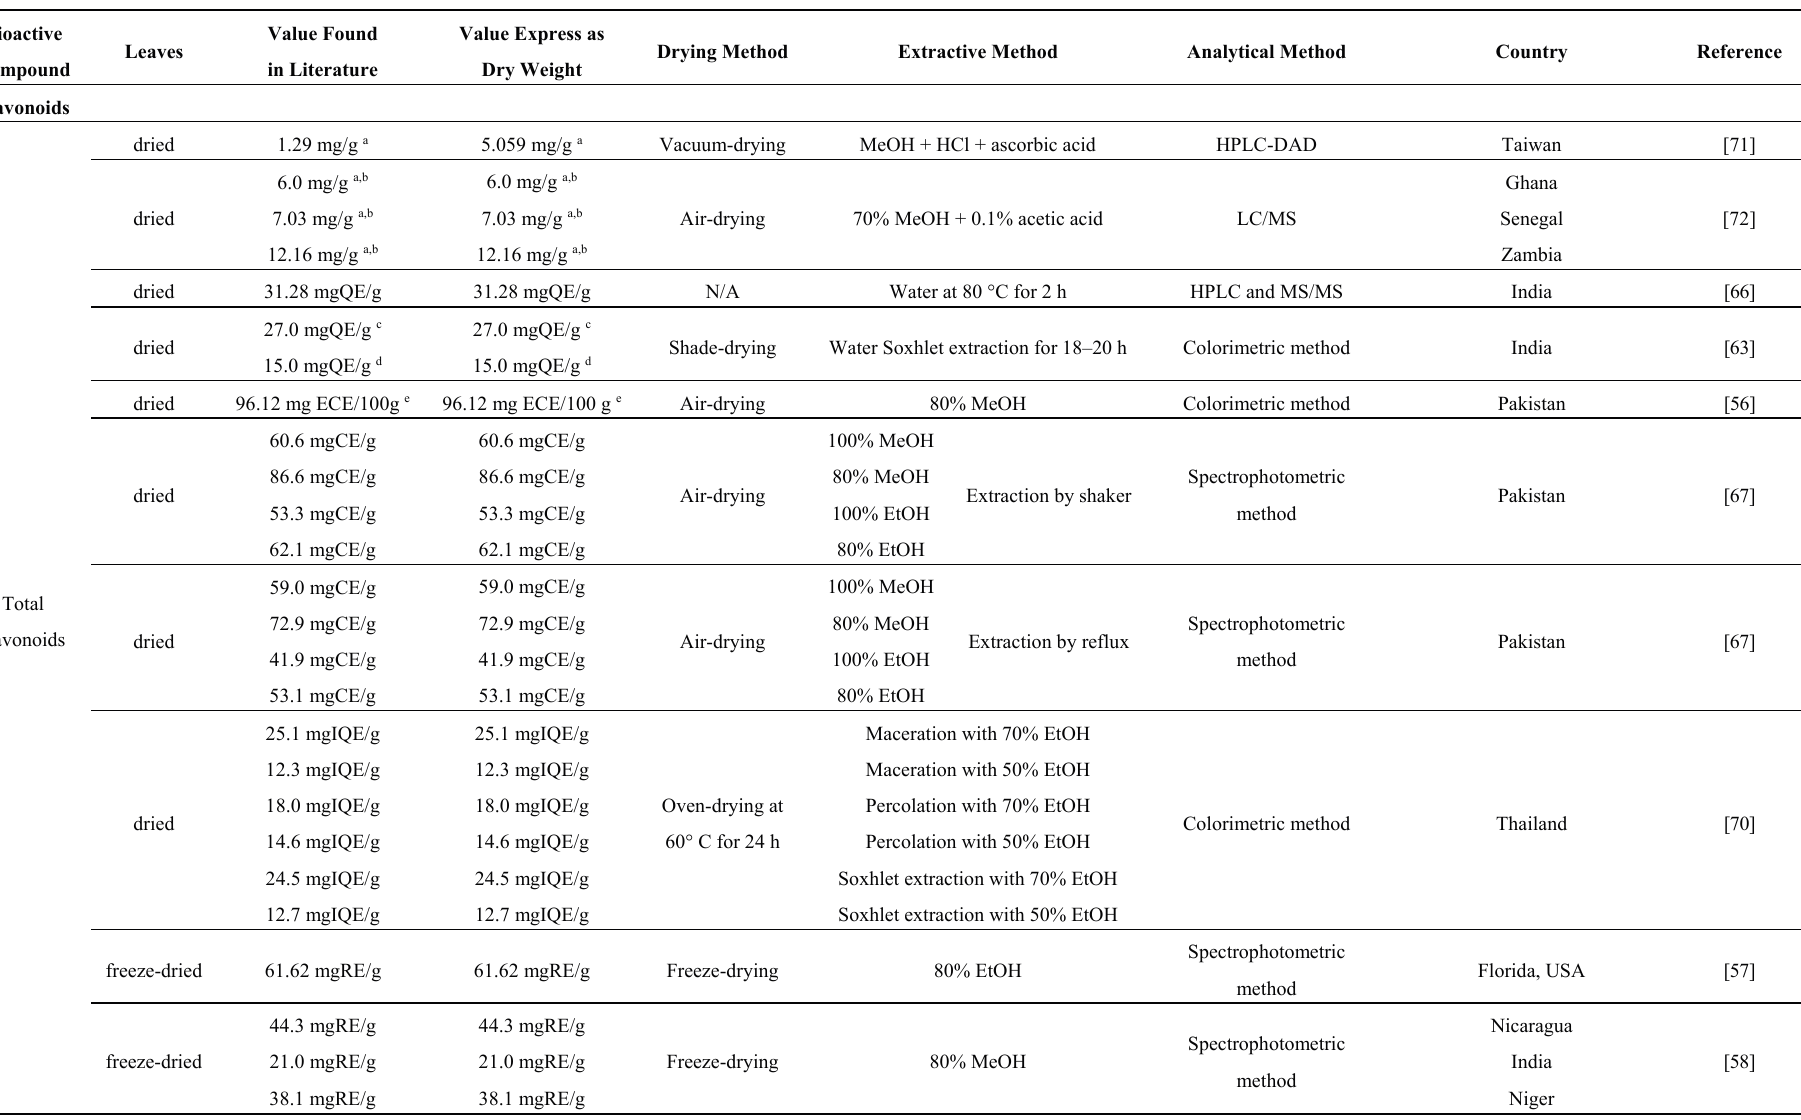
Table 5. Flavonoids content in Moringa oleifera